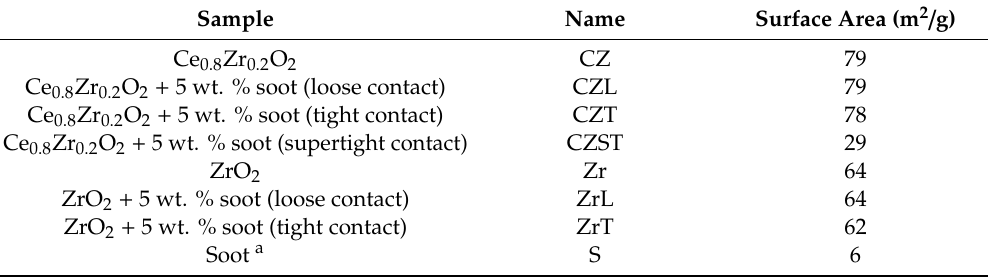
Table 1. Composition and textural characterization of investigated samples.